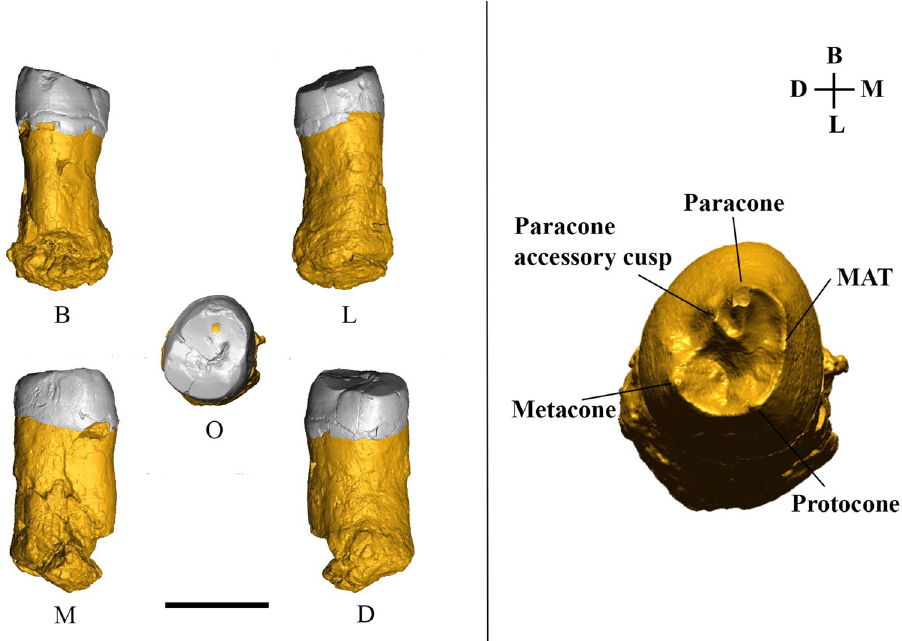
Figure 3. 3D digital model of specimen EQH2, an upper right third molar. Left: Various views—B, buccal; L, lingual; M, mesial; D, distal; O, occlusal. The black bar represents 1 cm. Right: The enamel-dentine junction (EDJ) surface of